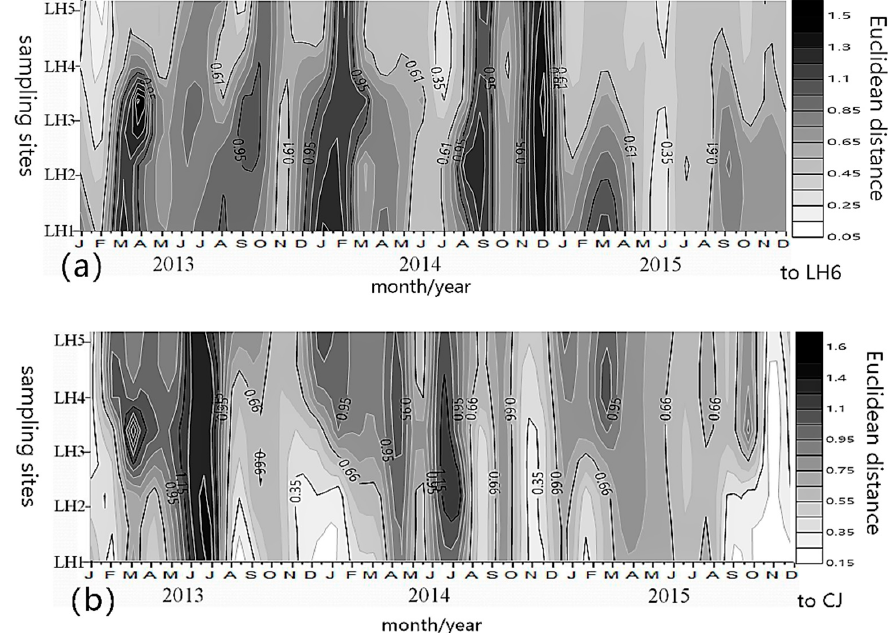
Figure 4. Variation of the distance coefficient between the sampling sites in LRB and the control sites: ( a ) to LH6, ( b ) to CJ.